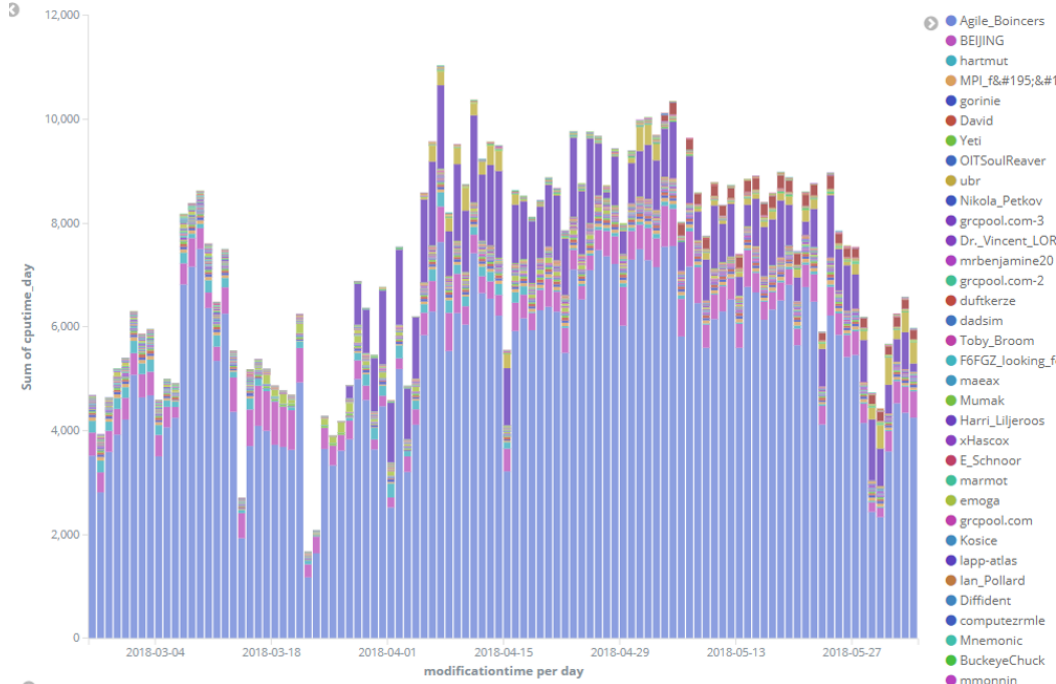
Figure 2. CPU time delivered by different ATLAS@home Table 4. CPU Utilization of TRIUMF site before and after backfilling